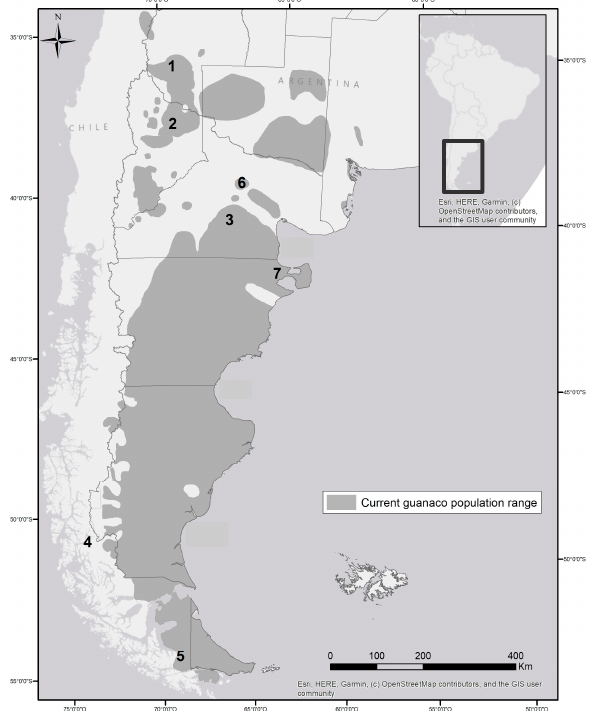
Figure 1. Current guanaco population range in Patagonia [from Baldi et al.’s unpublished manuscript] and locations where seasonal guanaco movements were studied: 1: [31], 2: Ovejero et al. [unpublished data], 3 and 7: Baldi et al. [unpublished data], 4: [32], 5: [33], and 6: [34].